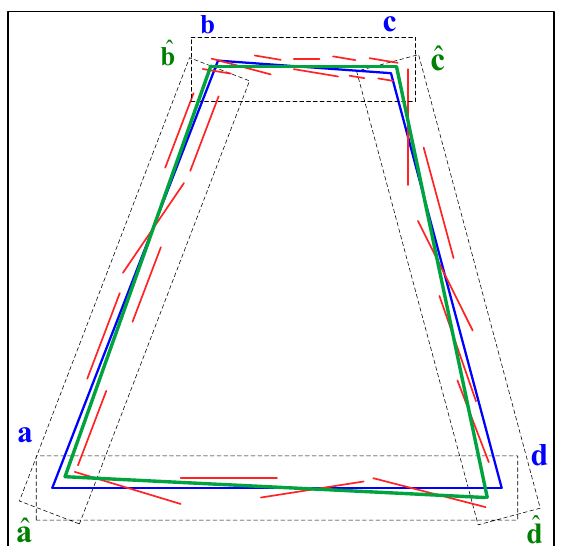
Figure 6. Real Runway Detection: the black solid rectangle is the runway ROI, the red lines are the extracted line segments, the blue quadrangle is the synthetic runway contour, the black dashed rectangles are the neighborhoods of runway edges, and the green quadrangle is the fitted runway